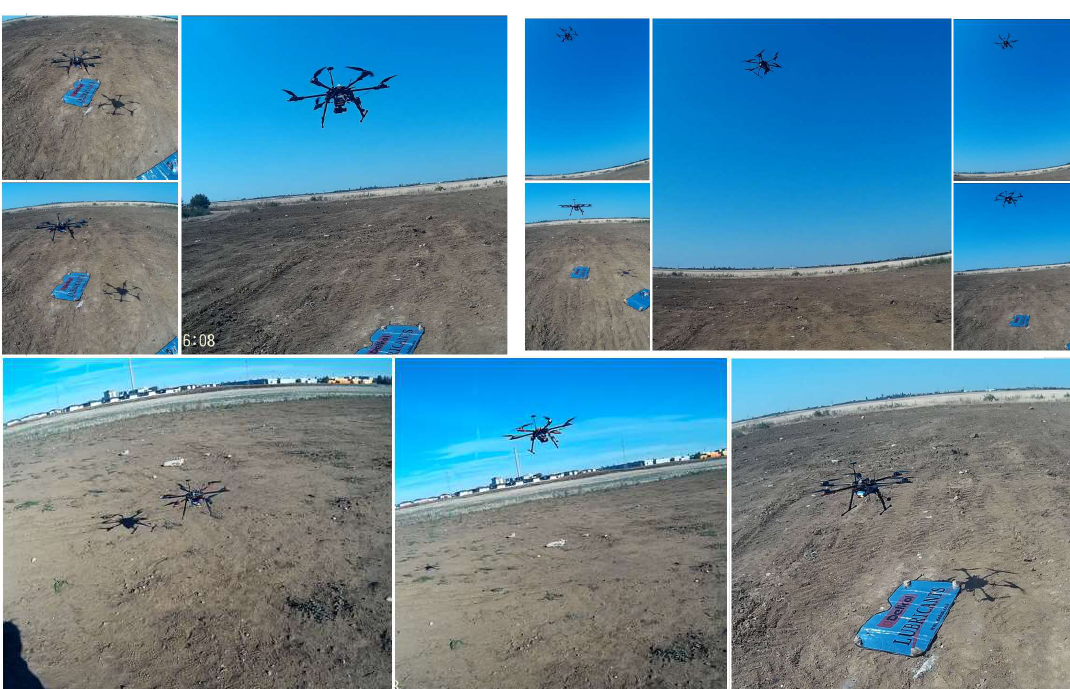
Figure 20. Hexacopter in stationary flight at a fixed point—flight stages.